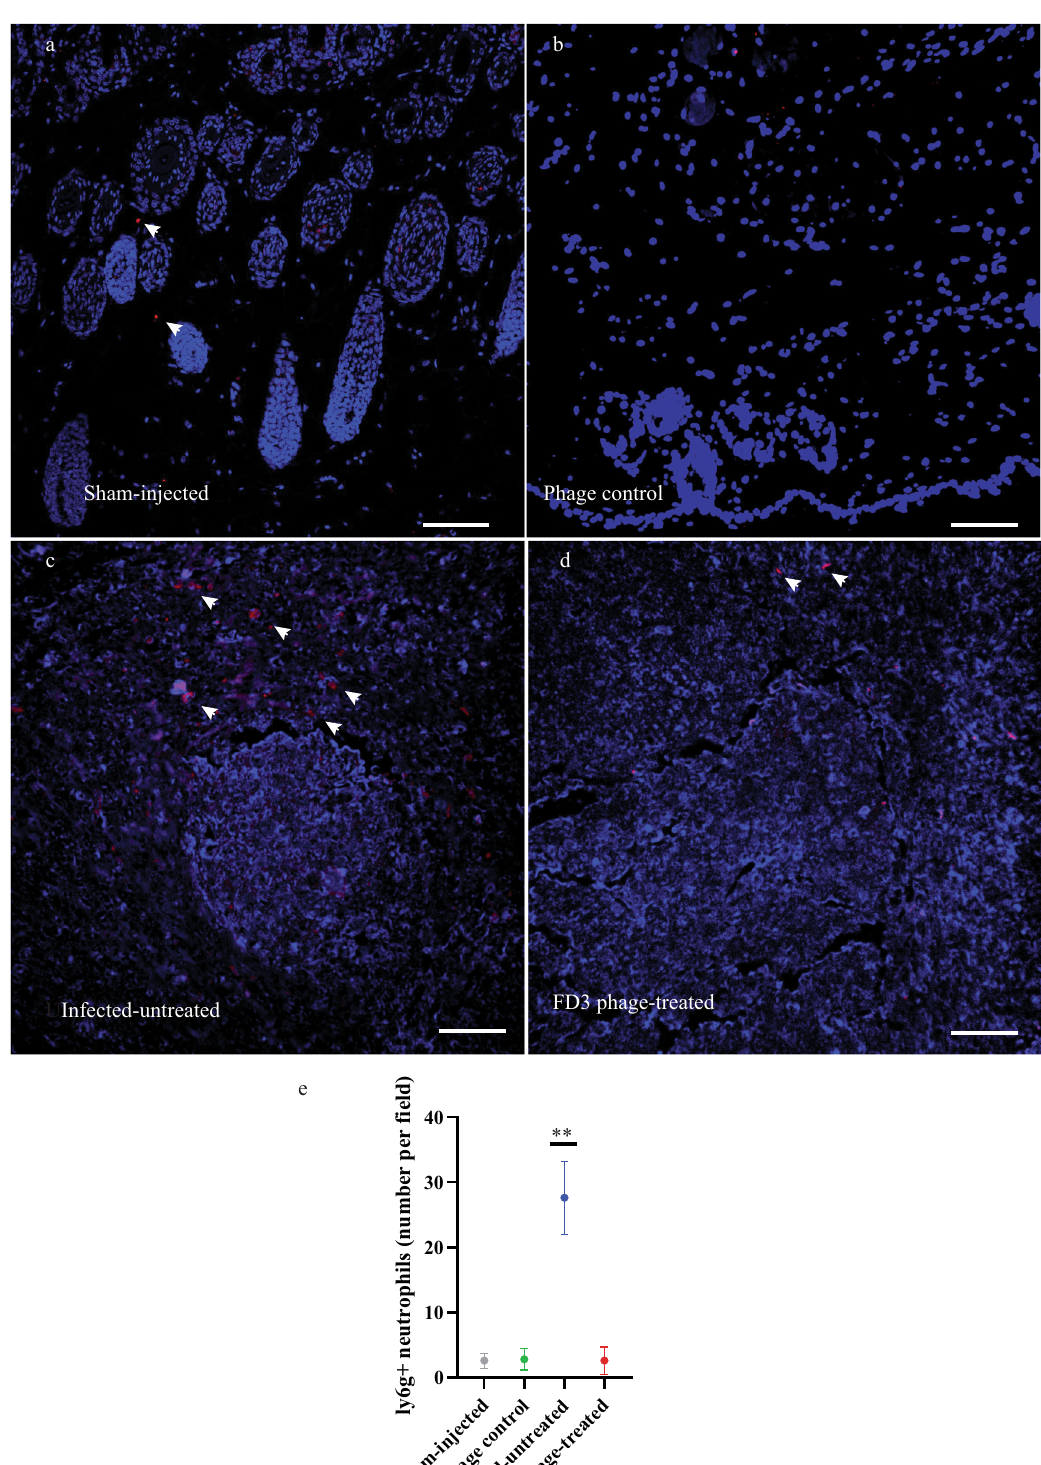
Fig. 5 | Immuno fl uorescencestaining ofLy6G+neutrophils.a – c anti-Ly6G (red) and DAPI (blue) were imaged with a fl uorescence microscope at ×20